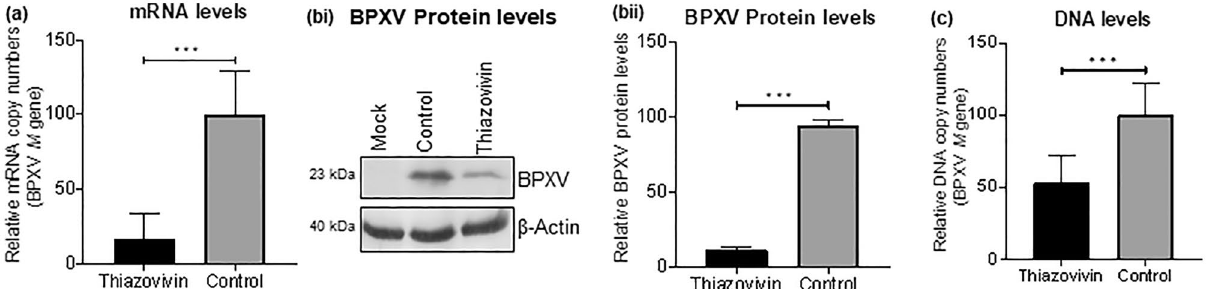
Figure 2. Effect of Thiazovivin on levels of BPXV mRNA/protein/DNA. ( a ) Viral mRNA. Confluent monolayers of Vero cells, in triplicates, were infected with BPXV (MOI of 5), followed by washing with PBS and addition of fresh medium. Inhibitor or vehicle-controls were applied at 4 hpi. Cells were scraped at 12 hpi to isolate RNA. cDNA was synthesized using oligo (dT) primers and quantified for BPXV M gene by qRT-PCR. Ct values were normalized with the β-actin housekeeping control gene and relative fold change was calculated by the ∆∆ Ct method. n = 3 independent experiments. ( b ) Viral proteins. Cells were infected with BPXV and treated with Thiazovivin as described above. The cell lysates were prepared at 24 hpi. The levels of viral (upper panel) and β-Actin house-keeping control protein (lower panel) were determined by Western blot analysis (bi). The histogram (bii) shows the band intensity of the protein. The blots were quantified by densitometry (ImageJ) and the data are presented as mean with SD. n = 3 independent experiments. See Supplementary Fig. 6a for full blots. ( c ) Viral DNA. Vero cells, in triplicates, were infected with BPXV and treated with Thiazovivin as described above. BPXV M gene in Thiazovivin-treated and vehicle-control-treated Vero cells were quantified by qRT-PCR. Ct values were normalized with the β-actin housekeeping control gene and relative fold change was calculated by the ∆∆ Ct method. n = 3 independent experiments. Error bars indicate SD. Pair-wise statistical comparisons were performed using Student’s t-test (***P < 0.001; **P <